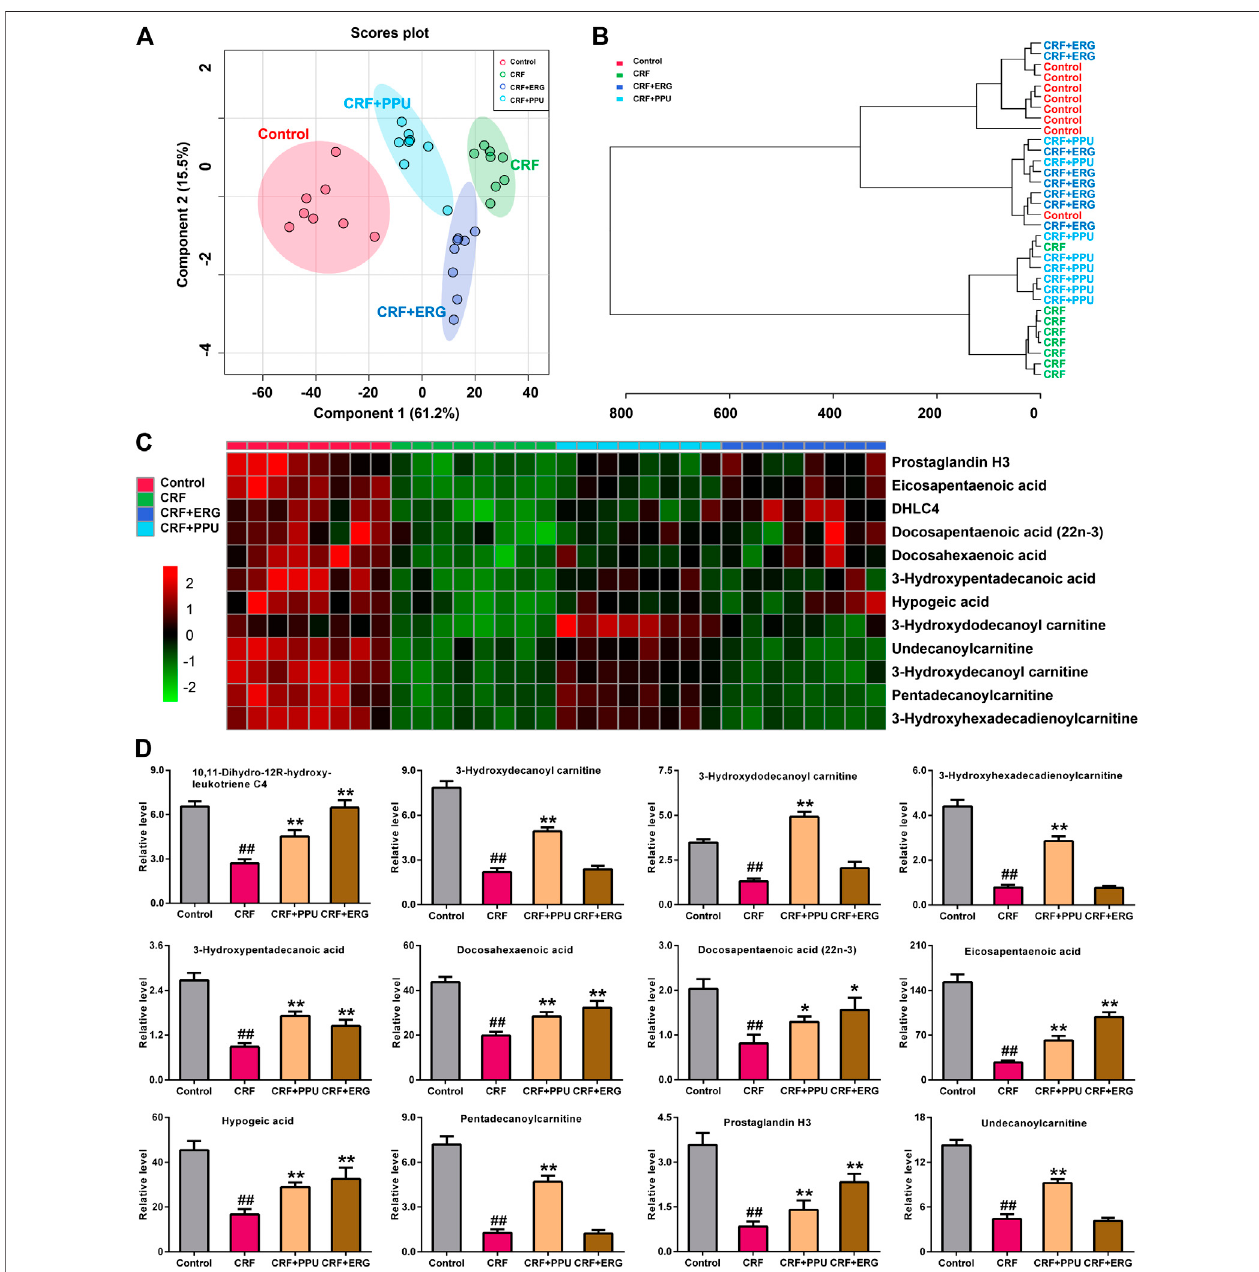
FIGURE7| TreatmentwithPPUandergoneimprovedaberrantfattyacidmetabolisminCRFrats. (A) sPLS-DAoftwocomponentsof12lipidspeciesfromcontrol, CRF,CRF+PPU, and CRF +ERGgroups. (B) Clusteringanalysis of12lipidspeciesamongcontrol, CRF, CRF +PPU, and CRF +ERGgroups. (C) Heatmap of12lipid speciesamongcontrol,CRF,CRF+PPU,andCRF+ERGgroups.Redandgreenindicateincreasedanddecreasedlevels,respectively. (D) Relativeintensityanalysisof 12lipid species amongthecontrol,CRF, CRF+PPU, andCRF +ERGgroups. # p < 0.05, ## p < 0.01compared withcontrolgroup; *p < 0.05, ** p < 0.01compared with CRF